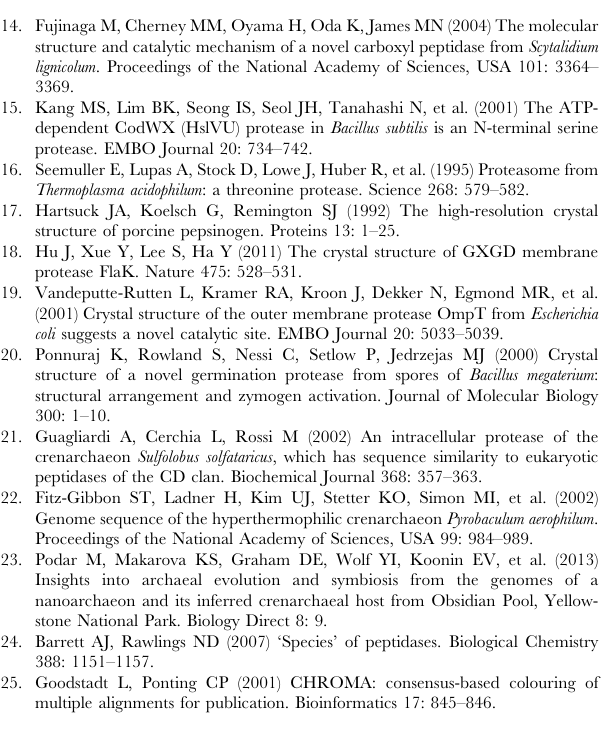
Figure S1 Alignment of peptidase domains from the thermopsin family A5. Sequences were aligned with ClustalW and are displayed using Chroma [25]. The alignment is numbered according to preprothermopsin. Potential active site residues mentioned in the text are